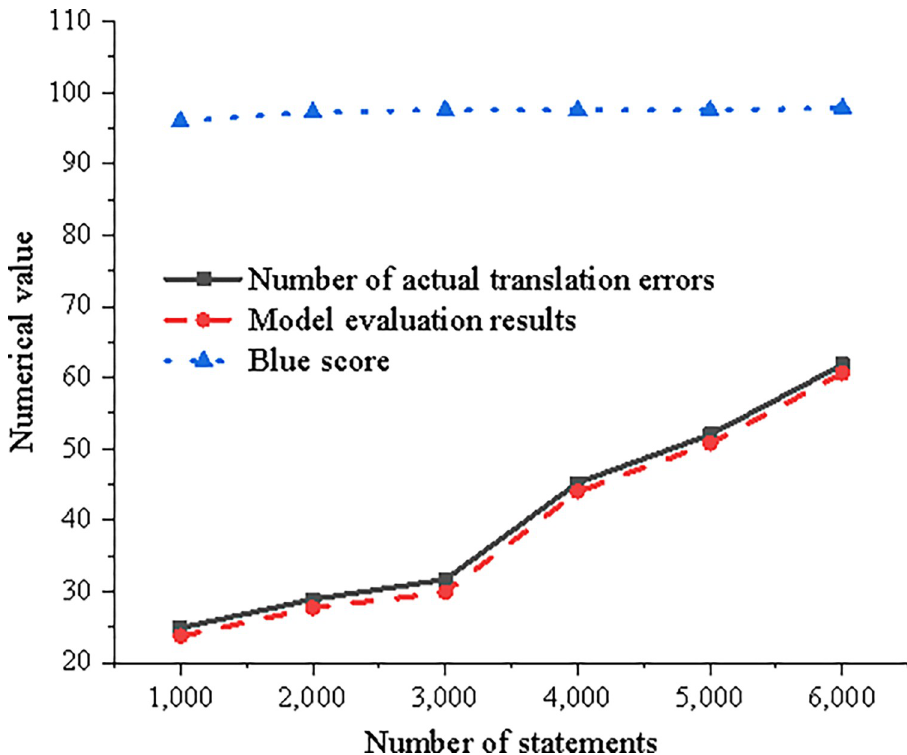
Fig 9. Proposed model evaluation performance affected by the number of